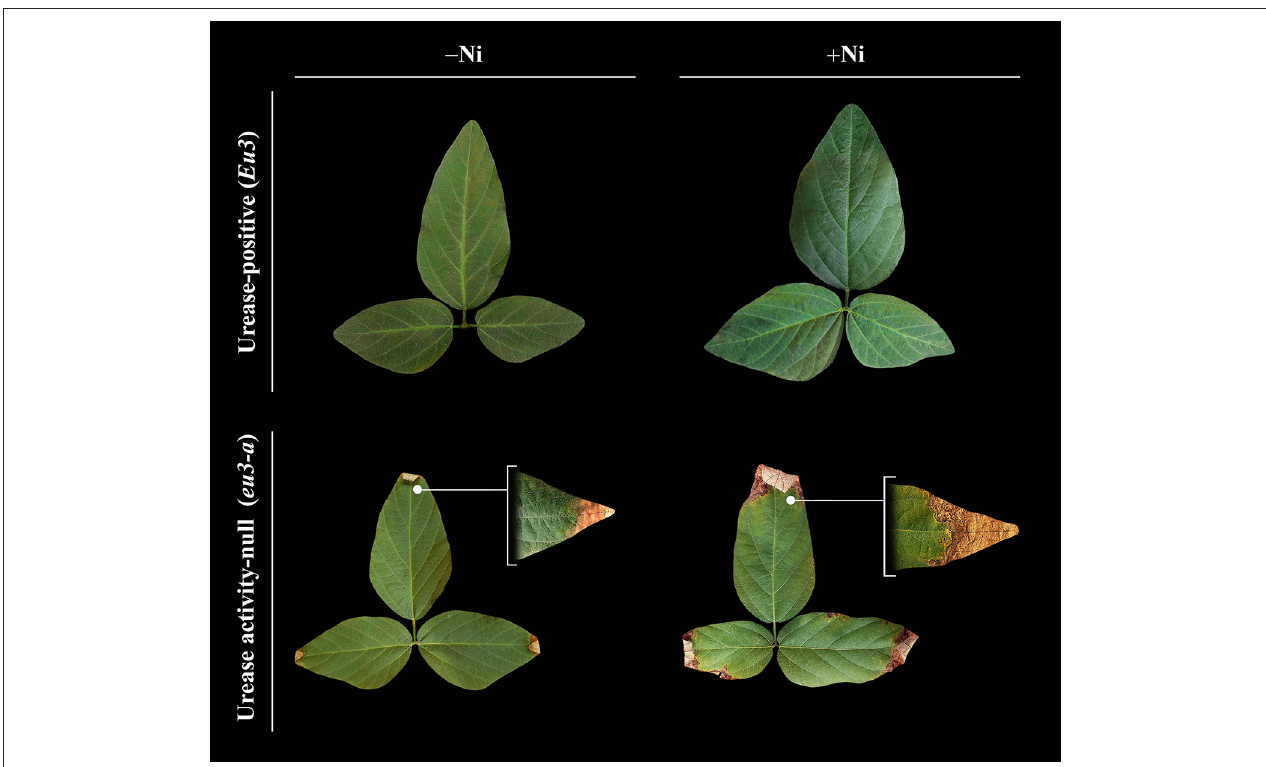
FIGURE 3 | Contrast of leaves of two near-isogenic soybean lines at flowering stage, urease-positive ( Eu3 ) and urease activity-null ( eu3-a ), fertilized with 0.0mg of Ni kg − 1 ( − Ni) and 0.5mg of Ni kg − 1 ( + Ni). Independently of Ni dose, Eu3 line developed normally while eu3-a line presented symptoms of hyponasty and initial necrosis lesions on leaflet tips. In eu3-a, these symptoms increased in the higher Ni dose due to excessive accumulation of